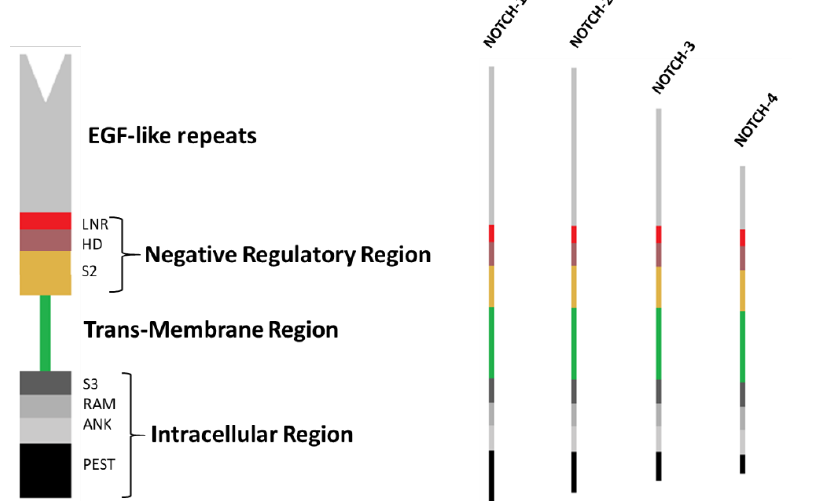
Figure 1. Structure of four human NOTCH receptors: NOTCH receptors are composed of an extracellular region of repetitive epidermal growth factor (EGF)-like sequences (29 – 36 repeats), a negative regulatory region, a single transmembrane portion and an intra-cytoplasmic tail involved in signal transduction. S2 and S3 are, respectively, the metalloprotease and γ -secretase sites of cleavage. EGF: epidermal growth factor; LNR: cysteine-rich LIN12-NOTCH repeats; HD: heterodimerization domain; RAM: recombining binding protein suppressor of hairless (RBPJ) associate module; ANK: ankyrin repeats; PEST: region rich in proline (P), glutamine (E), serine (S) and threonine (T) residues. The interaction between NOTCH receptors and their ligands initiates proteolytic cleavage of complex releases the NOTCH intracellular domain (NICD) of the receptor. NOTCH-NICD migrates into the nucleus where it binds to the recombining binding protein suppressor of hairless (RBPJ) and Mastermind-like (MAML) co-activators to assemble an active transcription complex on NOTCH-responsive genes (Figure